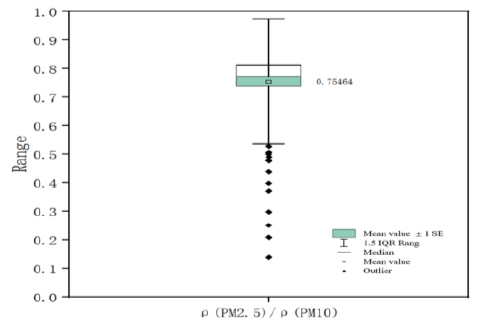
Figure 4. Statistical analysis results of (